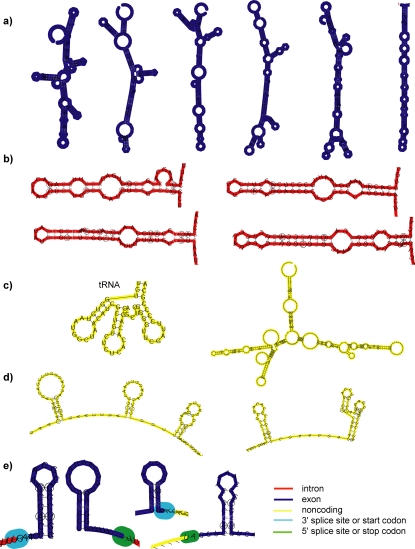
Examples of predicted secondary structure motifs by region of genome.a) Examples of long, branched hairpins found in exonic regions; b) New bulgy hairpin motif found in intronic regions; c) Examples of known or predicted noncoding RNAs found in intergenic regions; d) Examples of short hairpins found in 5′ UTR regions; e) Examples of short hairpins found just inside exons near exon boundaries (the most common type of motif in this region). Very few motifs were found in 3′ UTR regions.